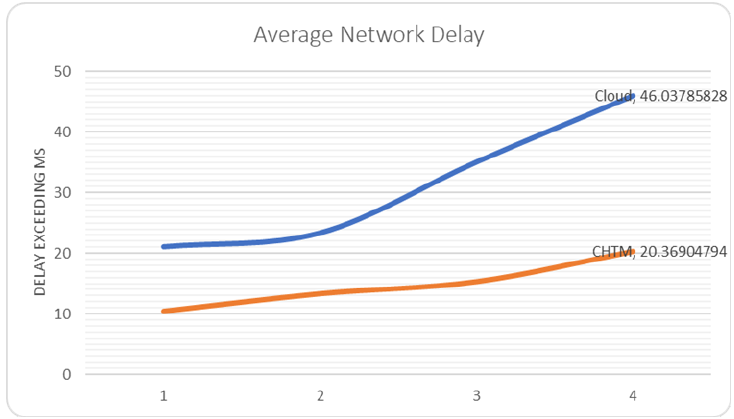
Figure 7. Average network delay